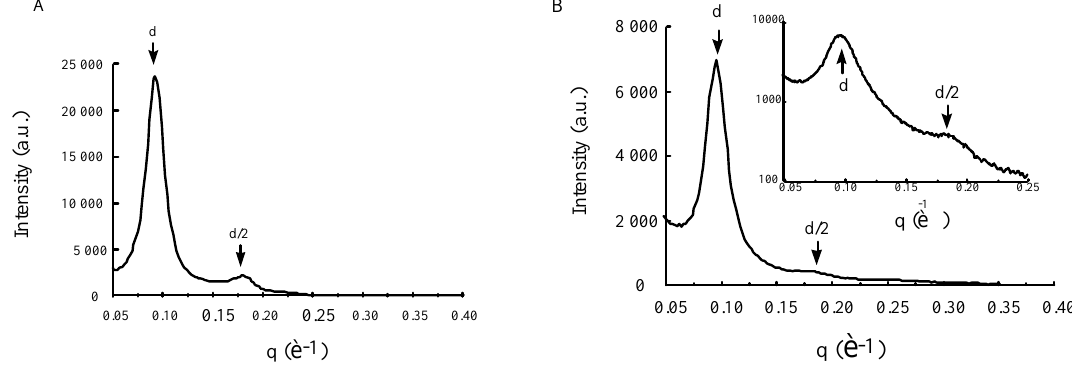
Figure 19. SAXS scans of BGTC/DOPE-DNA lipoplexes (A) and of BGTC-DNA lipoplexes (B). Cryo-TEM observation of an aqueous solution of BGTC showed threadlike ribbons about 15nm in width and 5nm thick; these ribbons were long, i.e., 1 micron. The structural features of BGTC/DNA lipoplexes were obviously quite different from the concentric multilamellar vesicles of cationic BGTC/DOPE-DNA complexes. Indeed, it appears that BGTC-DNA lipoplexes rather form